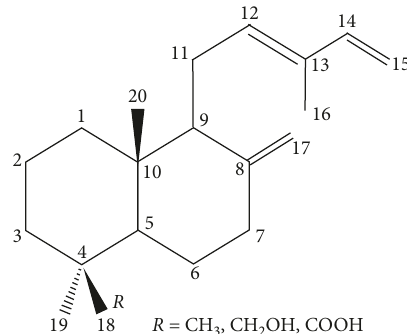
Figure 6: Structure of diterpenoid compounds.